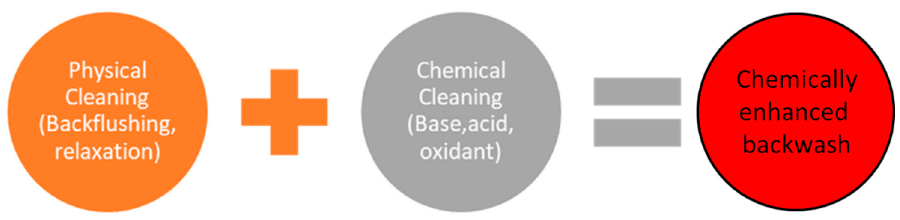
Figure 3. Membrane cleaning methods; physical cleaning, chemical cleaning, and their combination (chemically enhanced backwash).